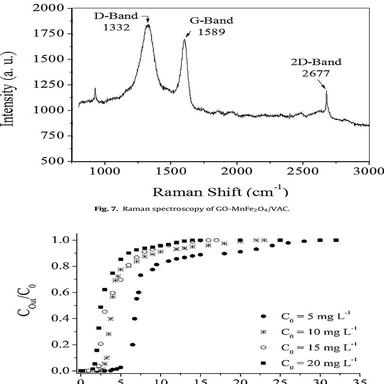
Influence of feed concentration on the glyphosate adsorption in the fixed-bed column (mads = 5 g, HT = 10 cm, Q = 8 mL min−1, pH ≈ 4.7 e T ≈ 25 ◦C).